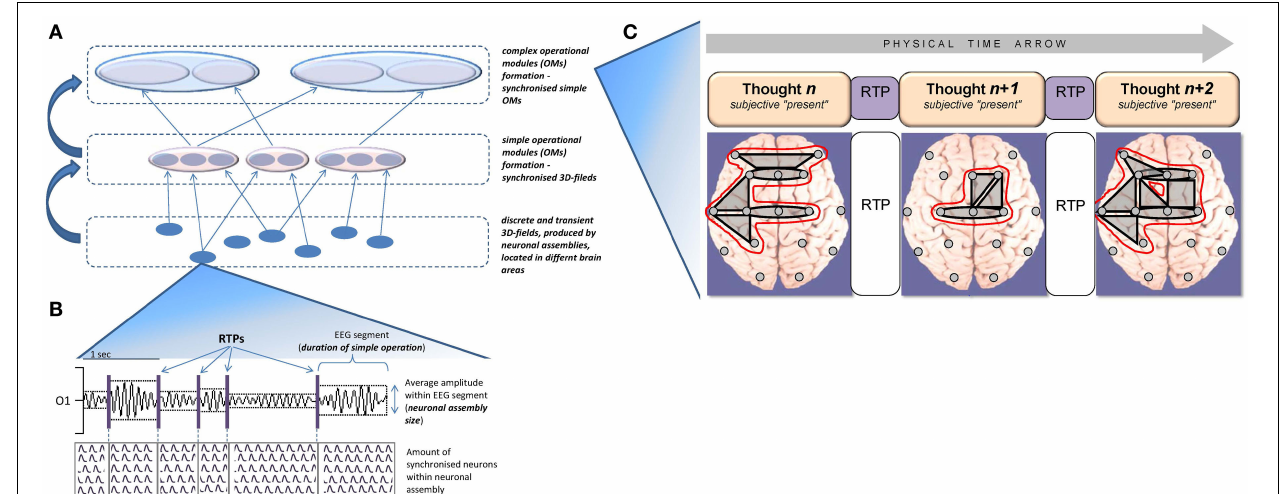
FIGURE 1 | Schematic representation of the nested functional hierarchy of spatiotemporal patterns of 3D electromagnetic fields produced by neuronal assemblies and operational modules formation, as well as their dynamics. (A) In a nested hierarchy, higher levels are physically composed of lower levels, and there is no central control of the system resulting in weak constraint of higher upon lower levels. (B) Illustration of the neuronal assembly’s dynamic and its relation to the EEG signal segments (for methodological details see Fingelkurts and Fingelkurts, 2008, in press); RTP, rapid transitional processes. Local EEG signal (O1-left occipital location) is filtered in alpha (7–13Hz) frequency band. (C) Diagram depicting dynamics of operational modules (OMs). Phenomenological level